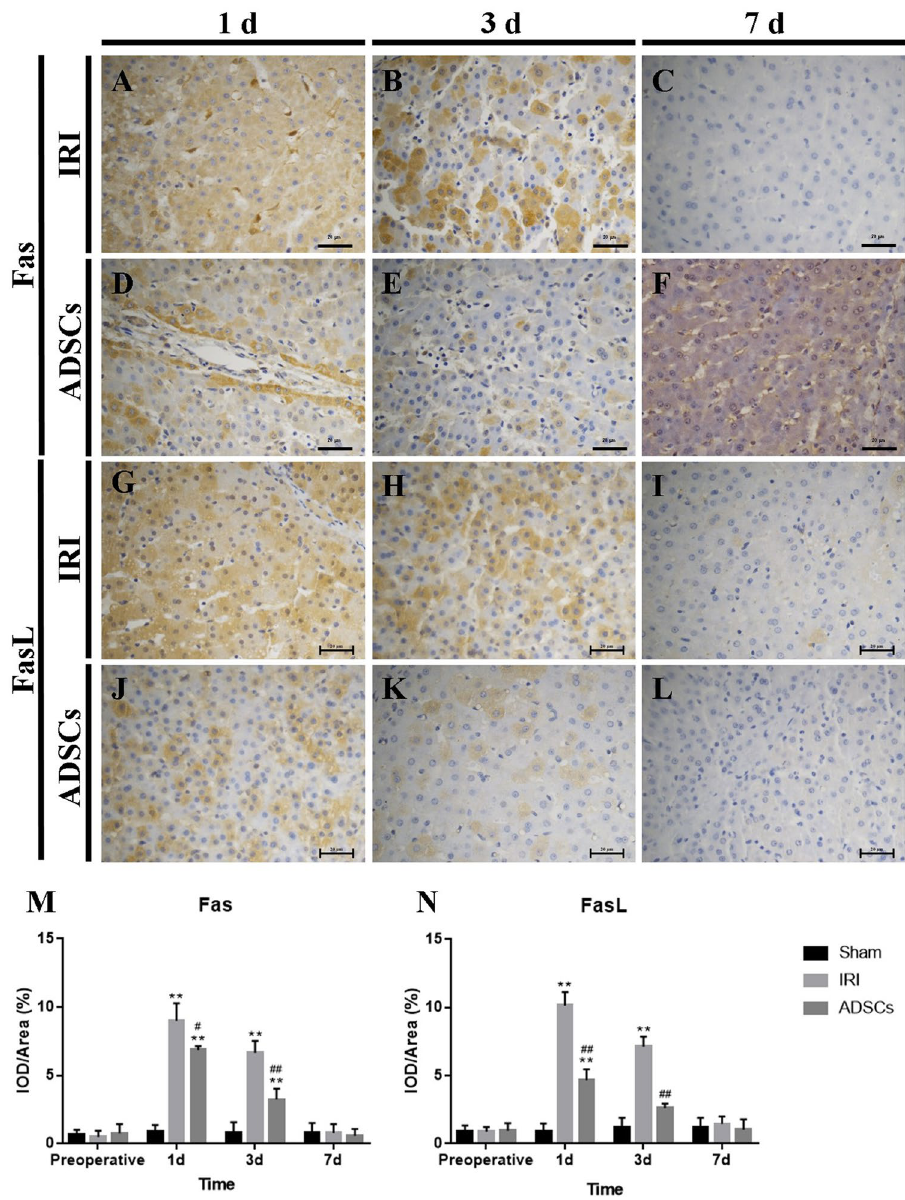
Figure 5. Fas and FasL immunohistochemistry staining of liver tissues. ( A – C ) Fas immunohistochemistry staining of the IRI group, 1 d, 3 d, and 7 d. ( D – F ) Fas immunohistochemistry staining of the ADSCs group, 1 d, 3 d, and 7 d. ( G – I ) FasL immunohistochemistry staining of the IRI group, 1 d, 3 d, and 7 d. ( J – L ) FasL immunohistochemistry staining of the ADSCs group, 1 d, 3 d, and 7 d (magnification × 400). ( M and N ) Fas and FasL expressions in liver tissues. **P < 0.01, vs. sham group, # P < 0.05, vs. IRI group, ## P < 0.01, vs. IRI